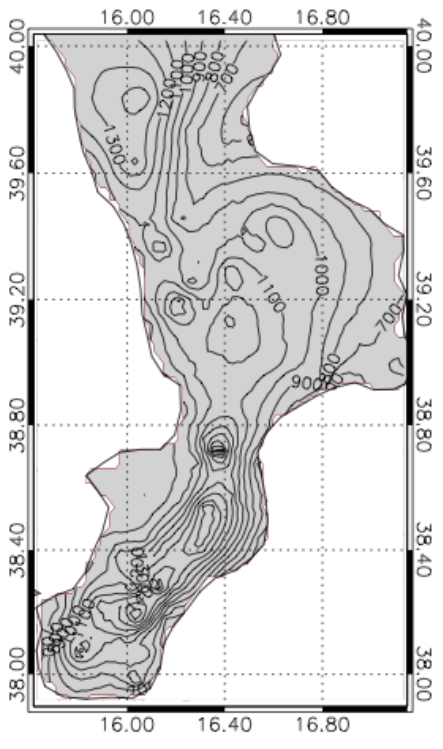
Fig. 2a. Annual precipitation over Calabria (average from 1970 to 2006). Contours from 600mm to 1500mm. Contour interval: 100mm.